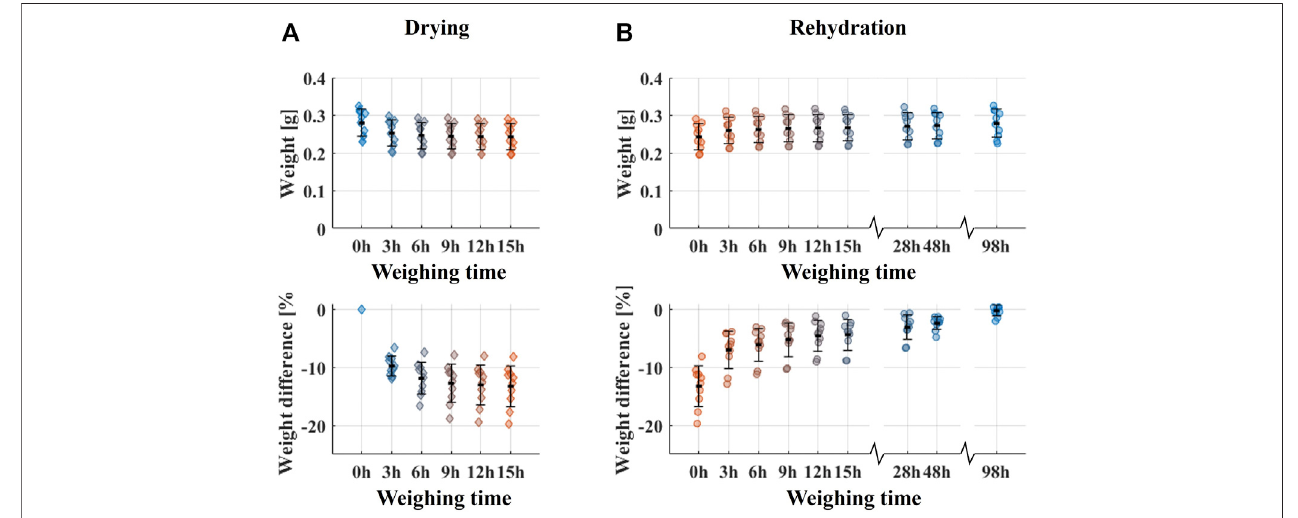
FIGURE6| Weight changesdue todrying and rehydration of10extratrabecularbovine bone plugs. (A) Weightand weight difference compared tooriginalweight during drying. (B) Weight and weight difference compared to original weight (before drying) during rehydration.